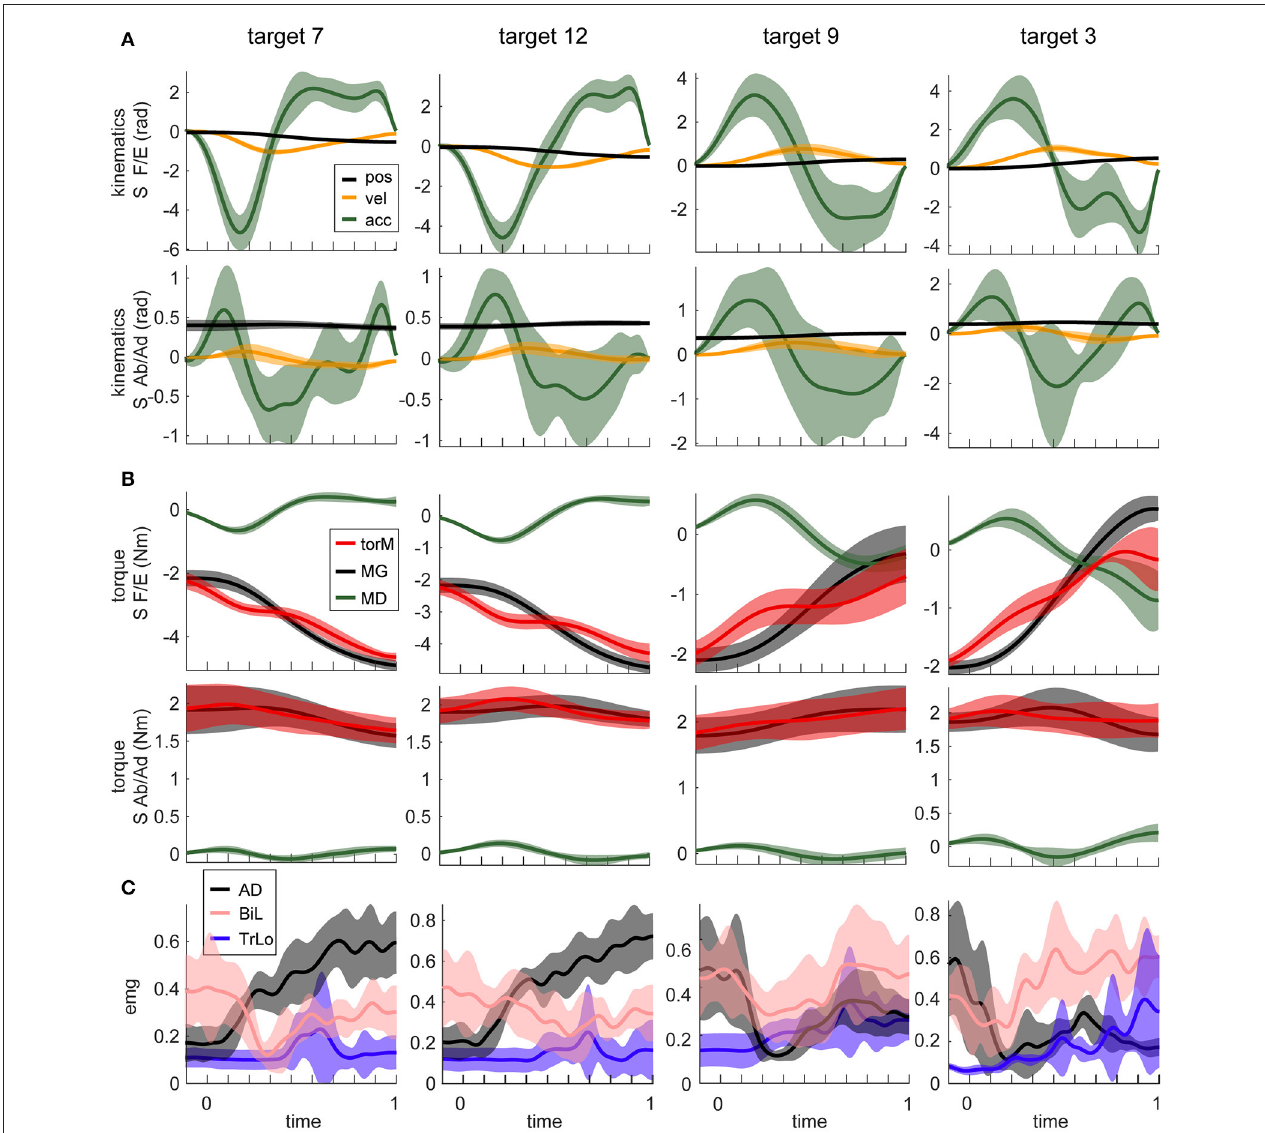
FIGURE 2 | Example motion signals and muscle activity, for a single subject. Columns show signals from movements to four different targets. Targets are numbered as in Figure 1 . Movements in the first 2 columns are adjacent to each other and orthogonal to those in the other 2 columns (see Figure 1 ). Lines are averages across 15 repetition of the same movement; shaded areas are standard deviations. (A) The temporal profiles of kinematic signals for two DOFs, shoulder flexion/extension (S F/E) and abduction/adduction (S Ab/Ad) are shown. (B) Dynamic signals calculated from signals in (A) . Muscle torques (torM) are the sum of MG and MD components. (C) EMG signals from three muscles for the corresponding movements. Muscle abbreviations are as described in the Methods section.